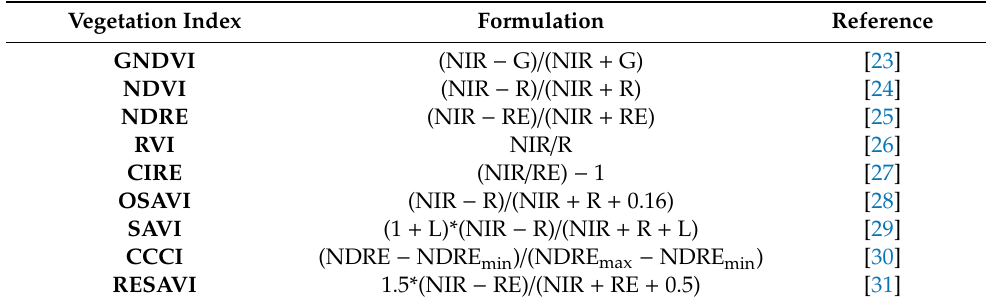
Table 2. Selected vegetation used for leaf area index, leaf dry matter, and yield